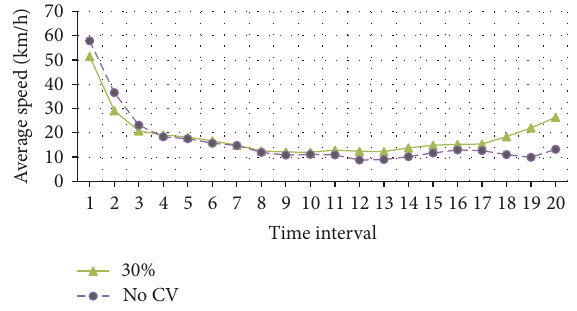
Figure 5: Cumulative percent benefits of 30 percent CV